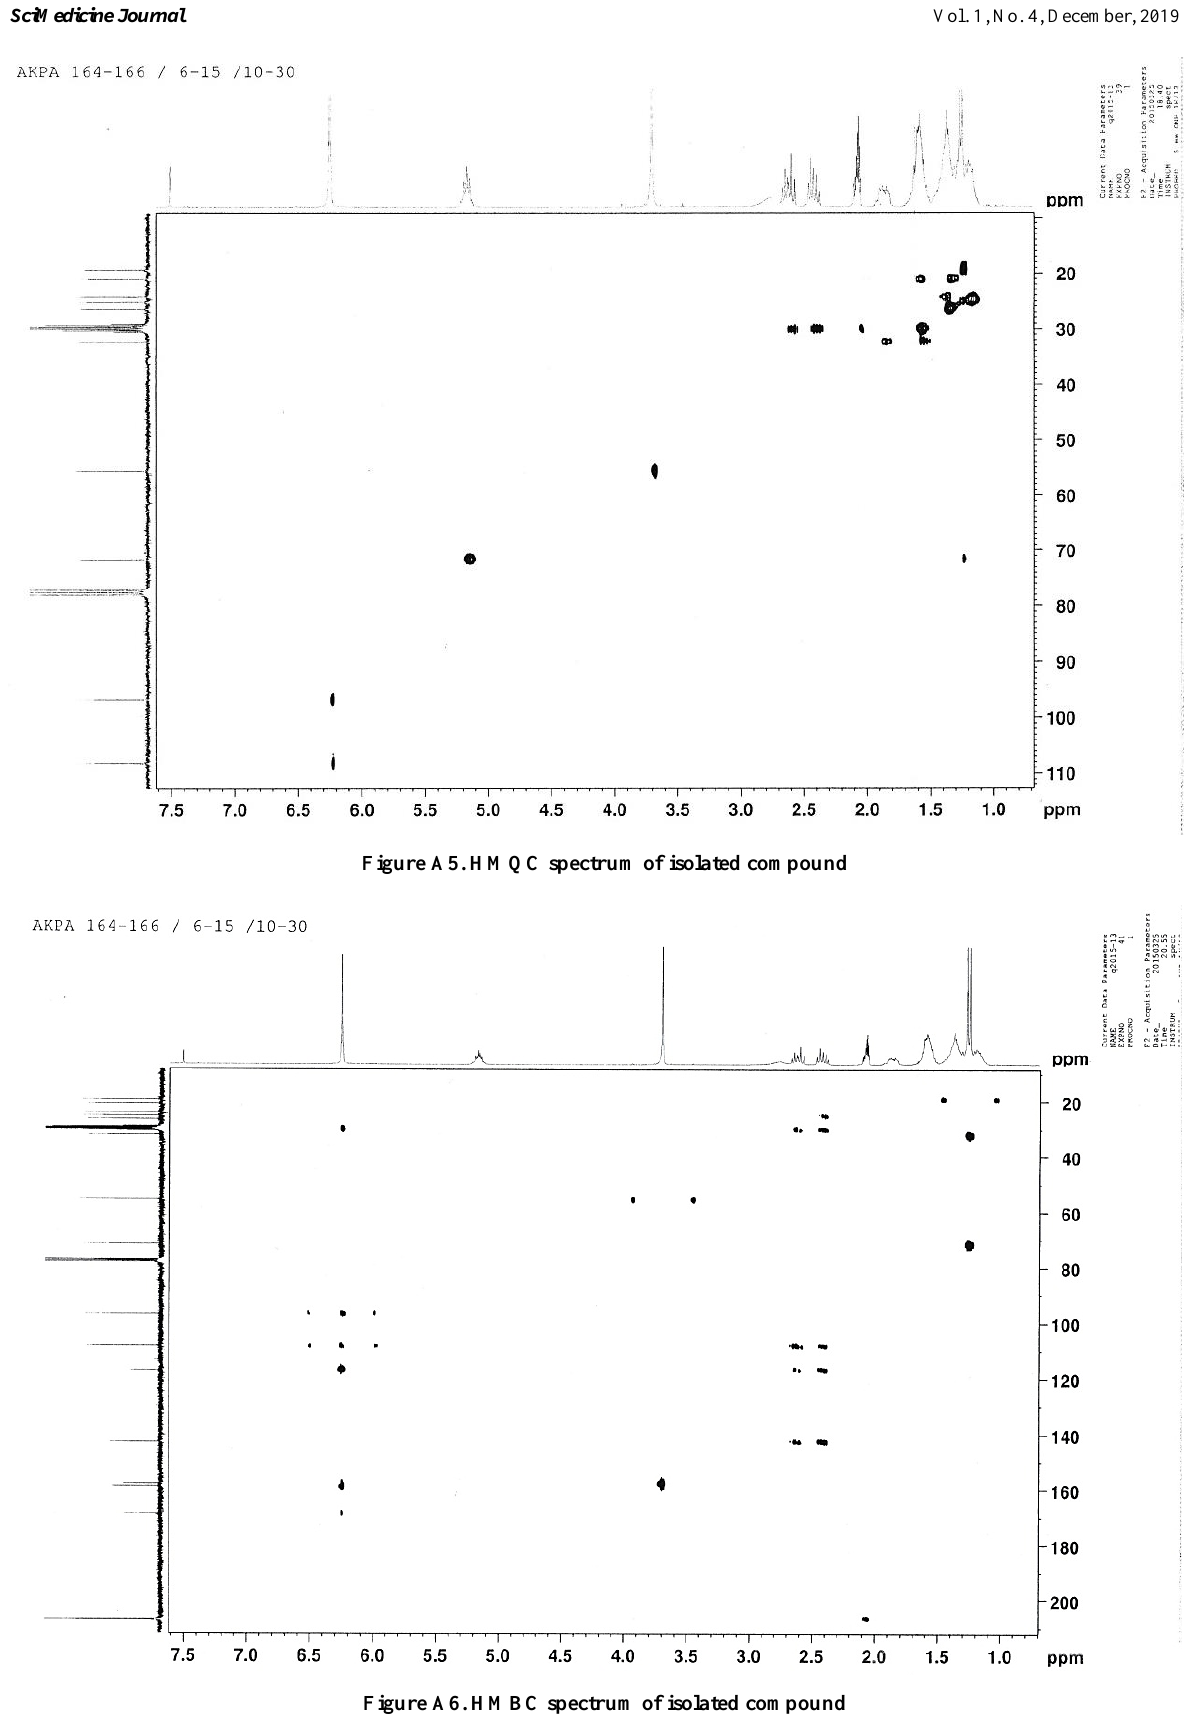
Figure A6. HMBC spectrum of isolated